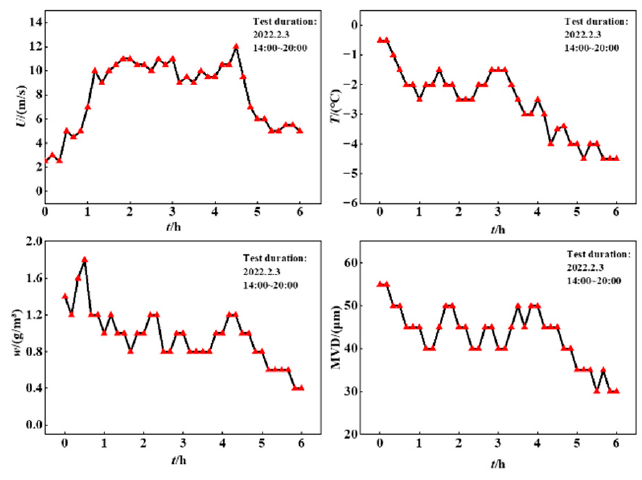
Figure 17. Environment parameters measured by multiple cylinders.